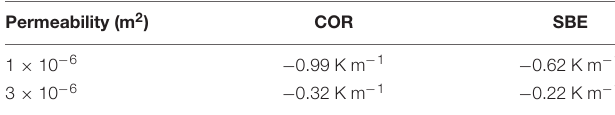
TABLE 3 | Critical temperature gradients in the active layer corresponding to Ra crit